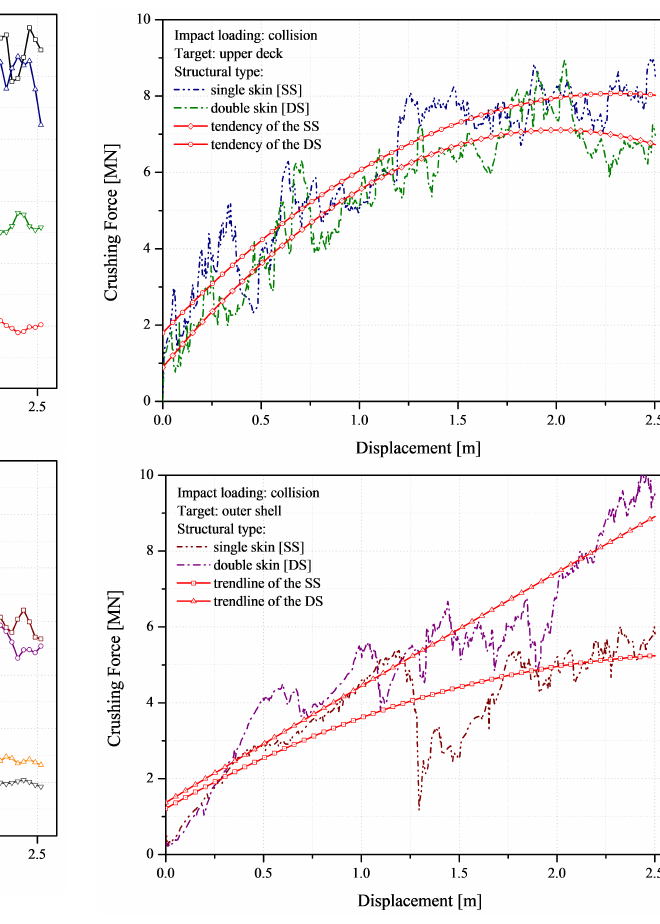
Figure 6: Crushing forces and their tendencies during